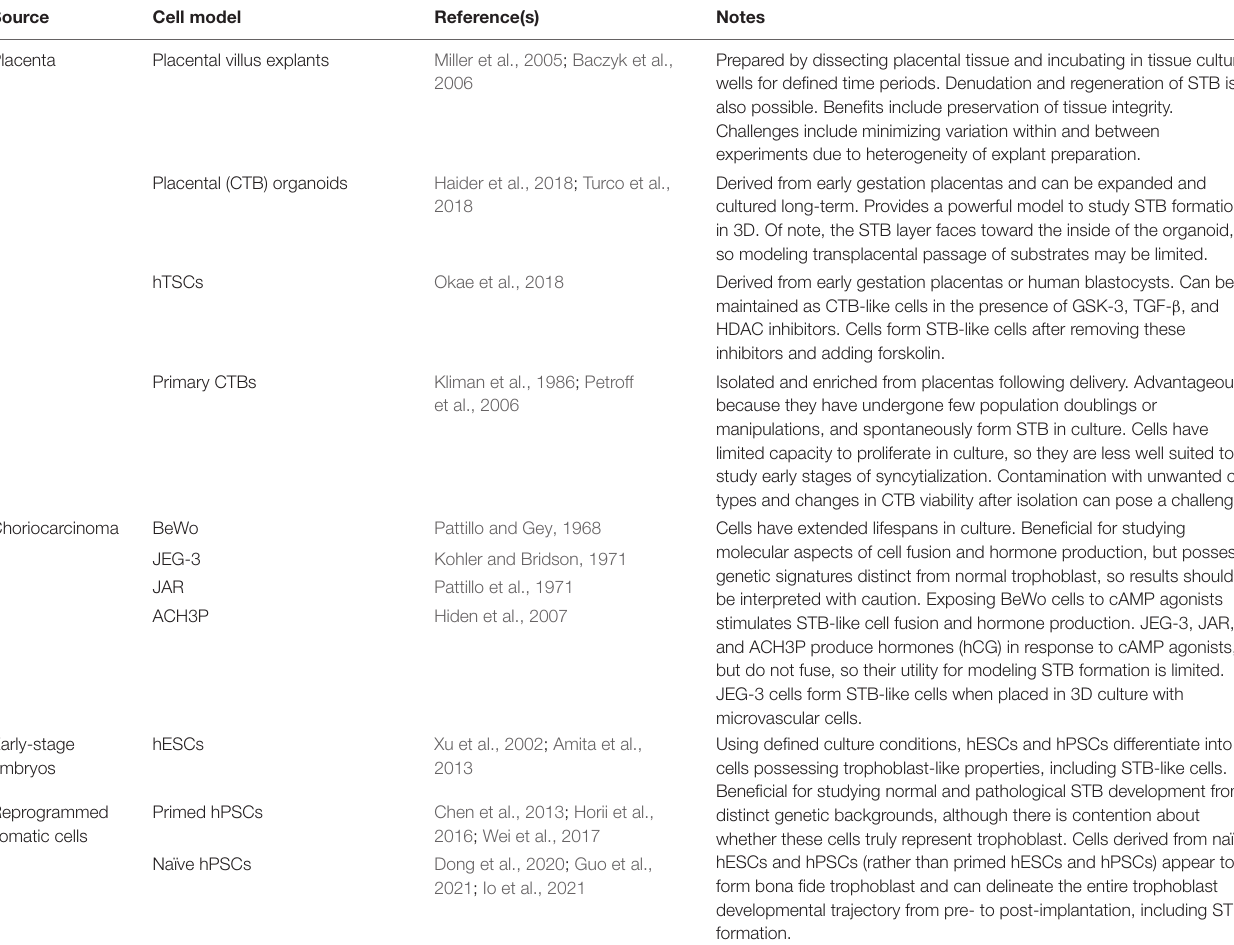
TABLE 1 | Cell models used to study STB development and